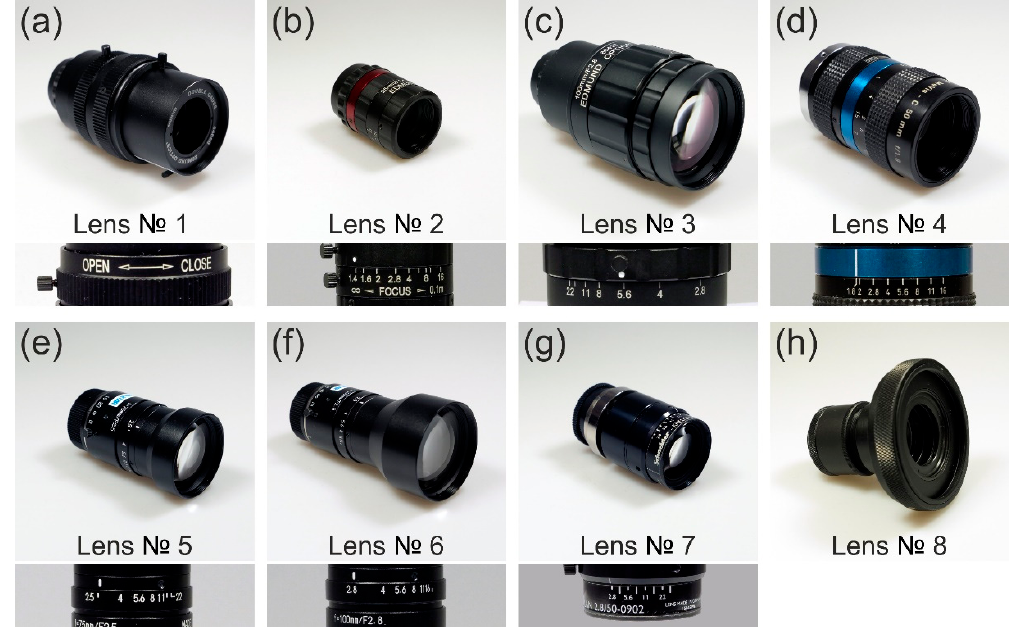
Figure 7. Camera lenses used for the experiments: ( a ) Edmund Optics 54690, ( b ) Edmund Optics 67715, ( c ) Edmund Optics 86410, ( d ) LINOS MeVis-C 1.8/50, ( e ) Navitar NMV-75, ( f ) Navitar NMV-100, ( g ) Schneider-Kreuznach Xenoplan 2.8/50 and ( h ) Thorlabs AC254-050-A (achromatic doublet).